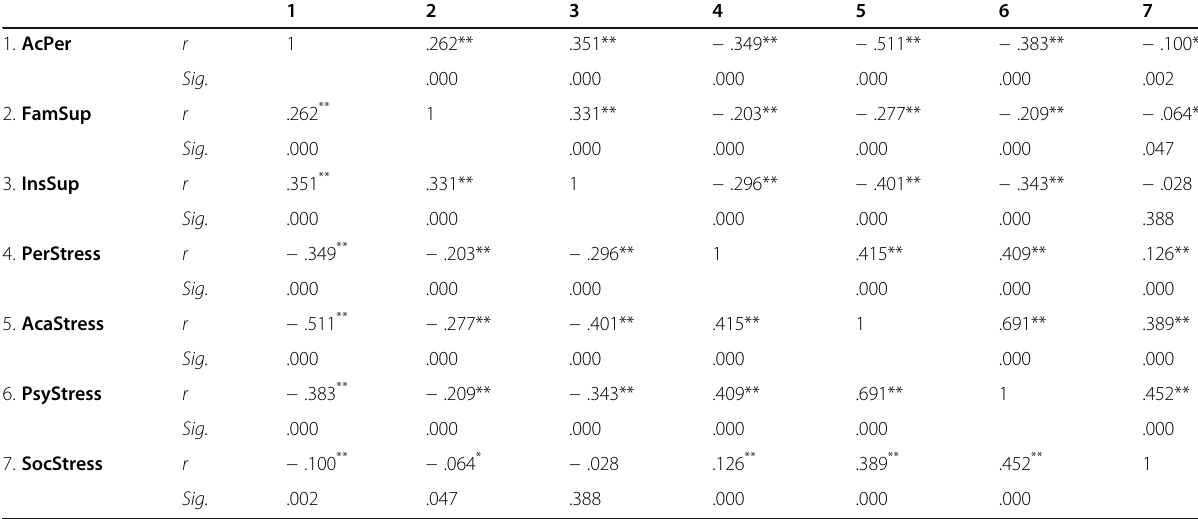
Table 5 Correlation among family support, social support, perceived stress, and academic performance